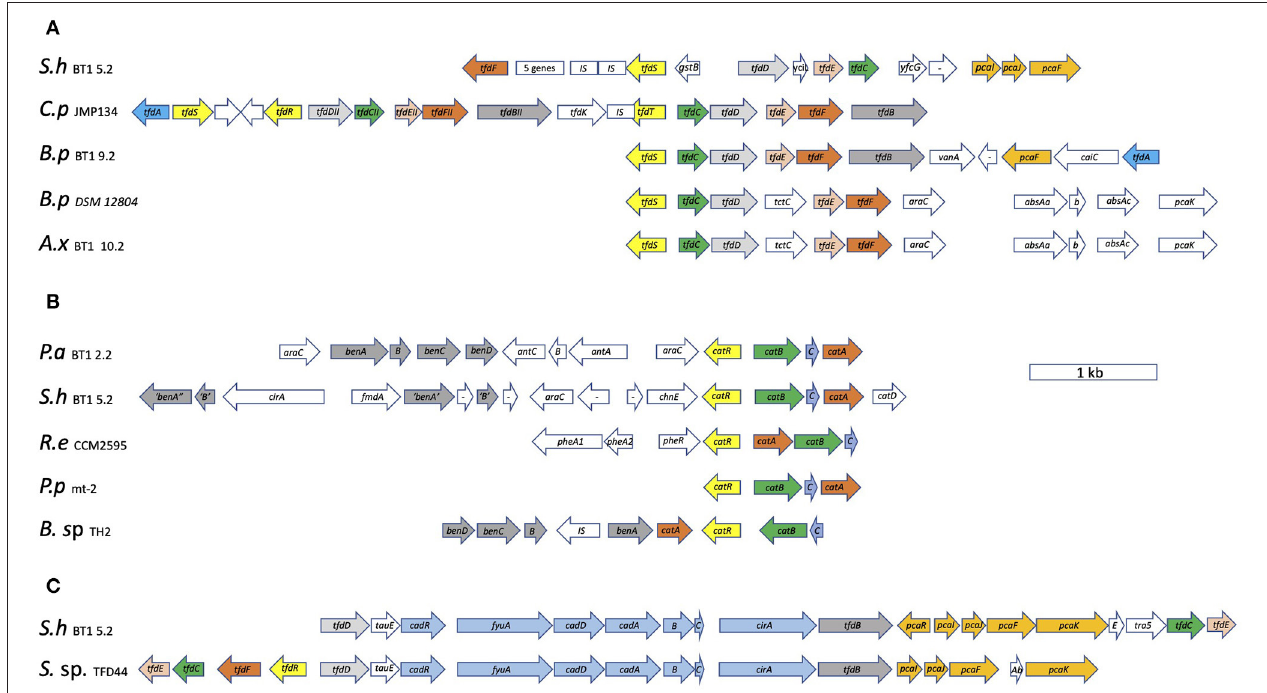
FIGURE 5 | Organization of the tfd gene clusters of B. petrii BT1 9.2, A. xylosoxidans BT1 10.2, and S. histidinilytica BT1 5.2, along with those from C. pinatubonensis JMP134 and B. pertussis DSM 12804 (A) , the tfd / cad gene cluster of S. histidinilytica BT1 5.2 along with that from Sphingomonas sp. ERG5 (B) , and of the cat gene clusters of P . aeruginosa BT1 2.2 and S. histidinilytica BT1 5.2 along with those from R. erythropolis CCM2595, P. putida mt-2, and Burkholderia sp. TH2 (C) . The arrows represent the transcription direction of the genes with their sizes reflecting their length in bp. P.a BT1 2.2 : P. aeruginosa BT1 2.2, S.h BT1 5.2 : S. histidinilytica BT1 5.2, B.p BT1 9.2: B. petrii BT1 9.2, A.x BT1 10.2: A. xylosoxidans BT1 10.2, C.p JMP134: C. pinatubonensis JMP134 (accession no. M35097.1 for the tfd I cluster and U16782.1 for the tfd II cluster), B.p DSM 12804: B. petrii DSM 12804 (accession no. AM902716.1), R.e CCM2595: R. erythropolis CCM2595 (accession no. FM995530.1), P.p mt-2 : P. putida mt-2, B. sp. TH2 : Burkholderia sp. TH2 (accession no. AB035483.1), S. sp. ERG5 : Sphingomonas sp. ERG5 (accession no.